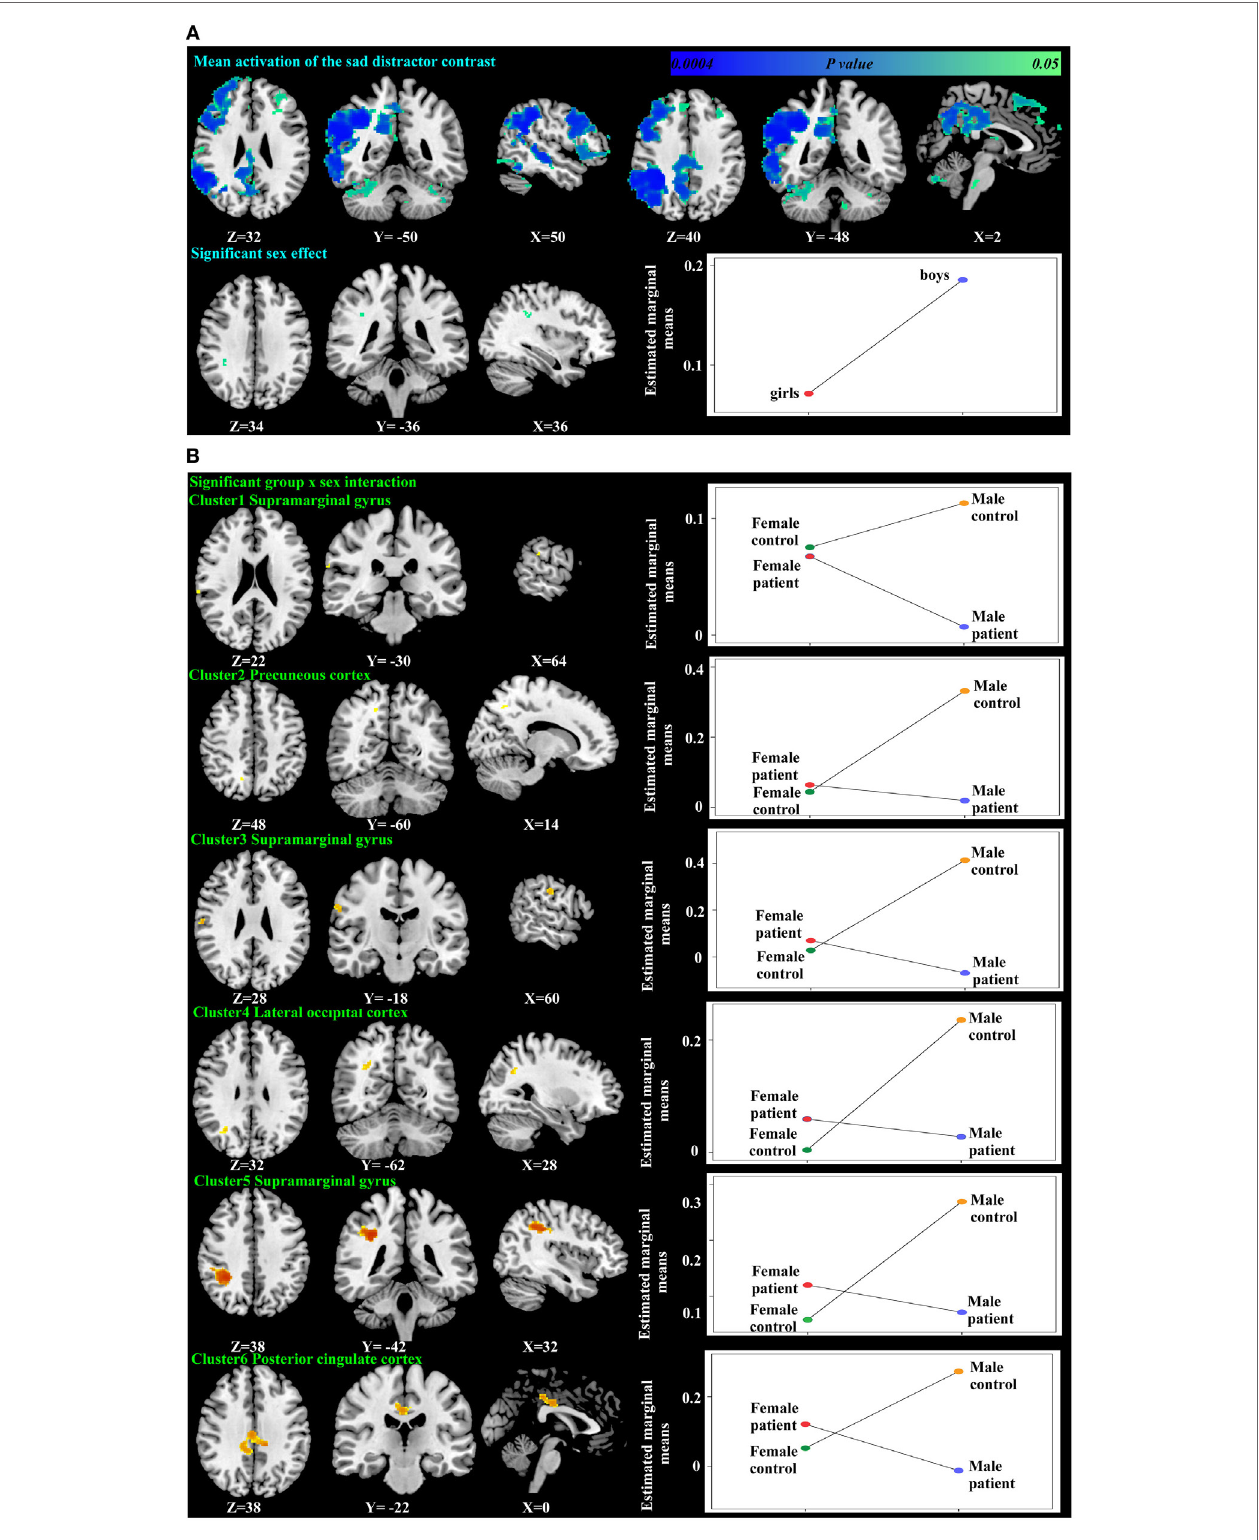
FigUre 3 | Significant mean activation, sex effect (a) and group-by-sex interaction (B) responding to the sad distractor contrast in all participants. Box plots depicted estimated marginal means of the percent signal changes extracted from the regions showing significant sex effect in the supramarginal gyrus (a) , and a group-by-sex interaction in the supramarginal gyrus, precuneus cortex, lateral occipital cortex, and the posterior cingulate cortex (B) .